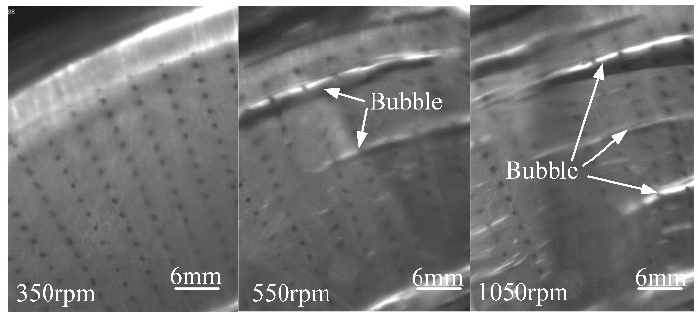
Figure 24. Cavitation morphology of oil film without texture.